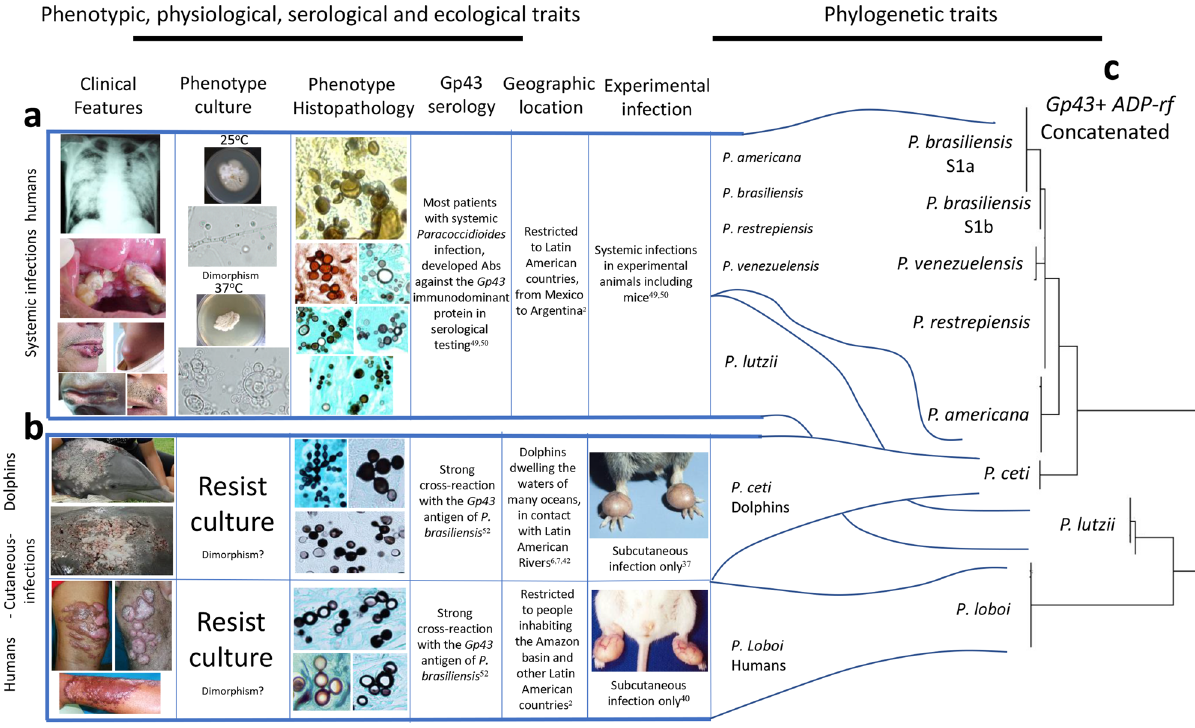
Figure 1. Clinical features, phenotypic, physiological, ecological, and other traits, group Paracoccidioides species into two clusters ( a , b ). Panel ( c ) display the phylogenetic analysis of 59 Gp43 and ADP-rf Paracoccidioides species concatenated partial DNA sequences (including four USA dolphin). The phenotypic features shared by P. americana , P. brasiliensis (sensu stricto), P. lutzii , P. restrepiensis and P. venezuelensis is shown in panel “a”. Panel “b” comprises common phenotypic features shared by P. cetii and P. loboi . The phylogenetic traits (Panel c ) using Gp43 and ADP-rf concatenated data in phylogenetic analysis, placed members of both clusters ( a , b ) on inverted phylogenetic groups. For instance, P. lutzii grouped with P. loboi whereas P. cetii clustered with the other Paracoccidioides species. However, without the inclusion of P. cetii DNA sequences, P. loboi would appear as an independent genus, as described by others 15,16,24,25 . (Clinical picture in panel b were courtesy of Drs. J. St. Leger, G. D. Bossart, L. Ajello, and P.